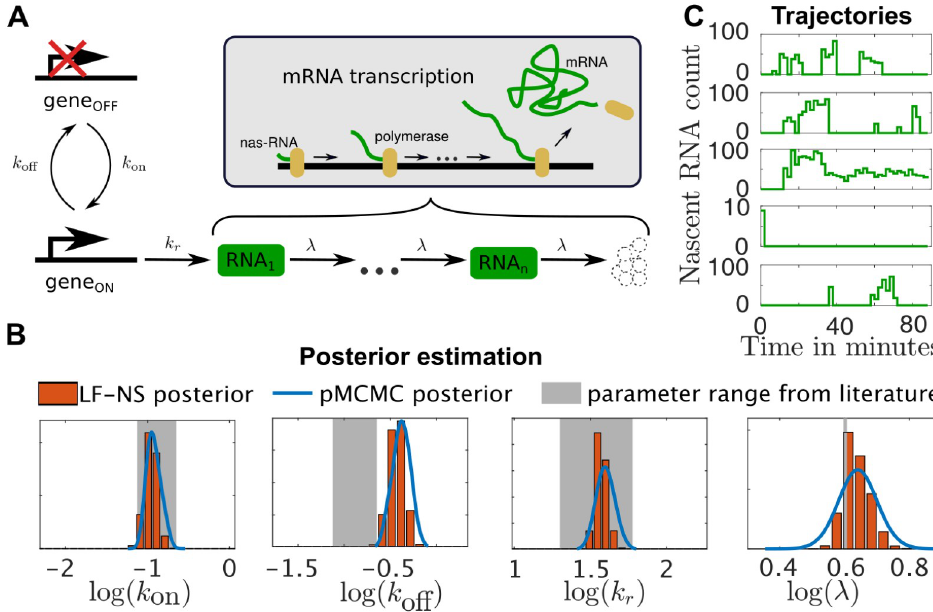
Fig 5. Inference on the transcription model. A : Schematic representation of the gene expression model. The model consists of a gene that switches between an “on” and an “off” state with rates k on and k off . When “on” the gene is getting . The transcription process is modelled through n RNA species that sequentially transform from transcribed at rate k r one to the next at rate λ . The observed species are all of the intermediate RNA i species. B : The marginal posterior distribution of the parameters of the system. The histogram indicates the posterior obtained through LF-NS, the blue line indicates the posterior obtained from a long pMCMC run and the shaded areas indicate the parameter ranges that were considered in [58]. The scale of the x-axis does not represent the range of the prior and has been chosen for presentational purposes. C : The five trajectories used for the parameter inference.